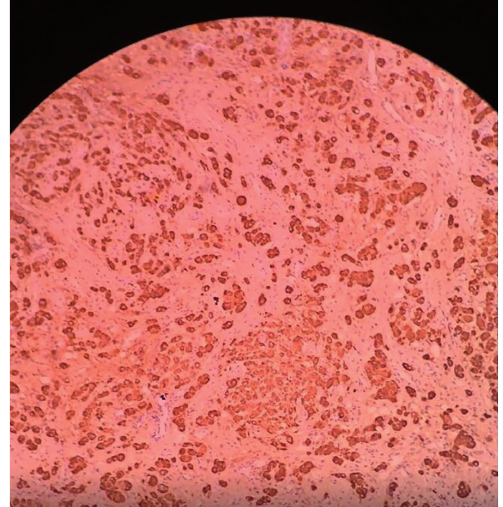
Figure 6 - Melan-A antibody